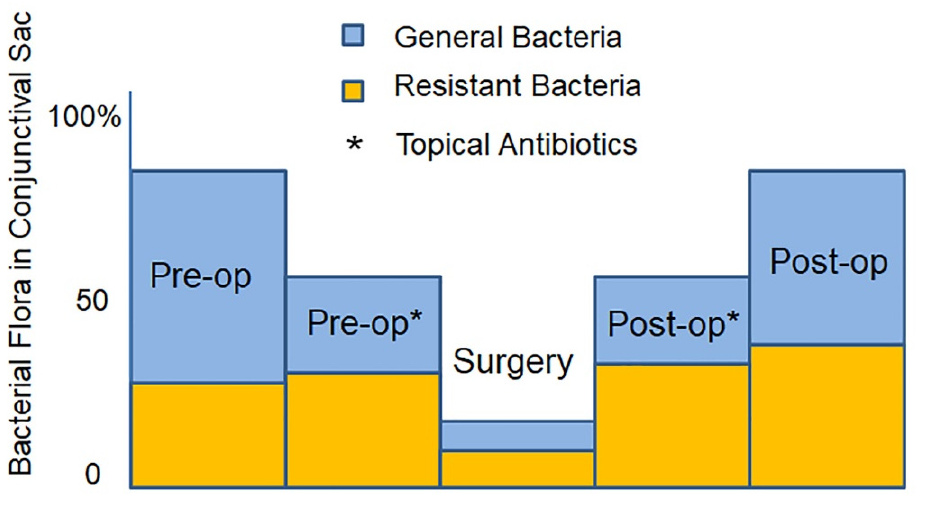
Figure 1. Using antibiotic eye drops before and after surgery and washing with saline during surgery. Preoperative use of antibiotic eye drops not only has limited disinfection effect, but the procedure also increases the proportion of resistant bacteria after surgery. Washing with saline during surgery only reduces the number of bacteria on the ocular surface, and the risk of bacteria entering the eye remains. (Authors’ unpublished images).